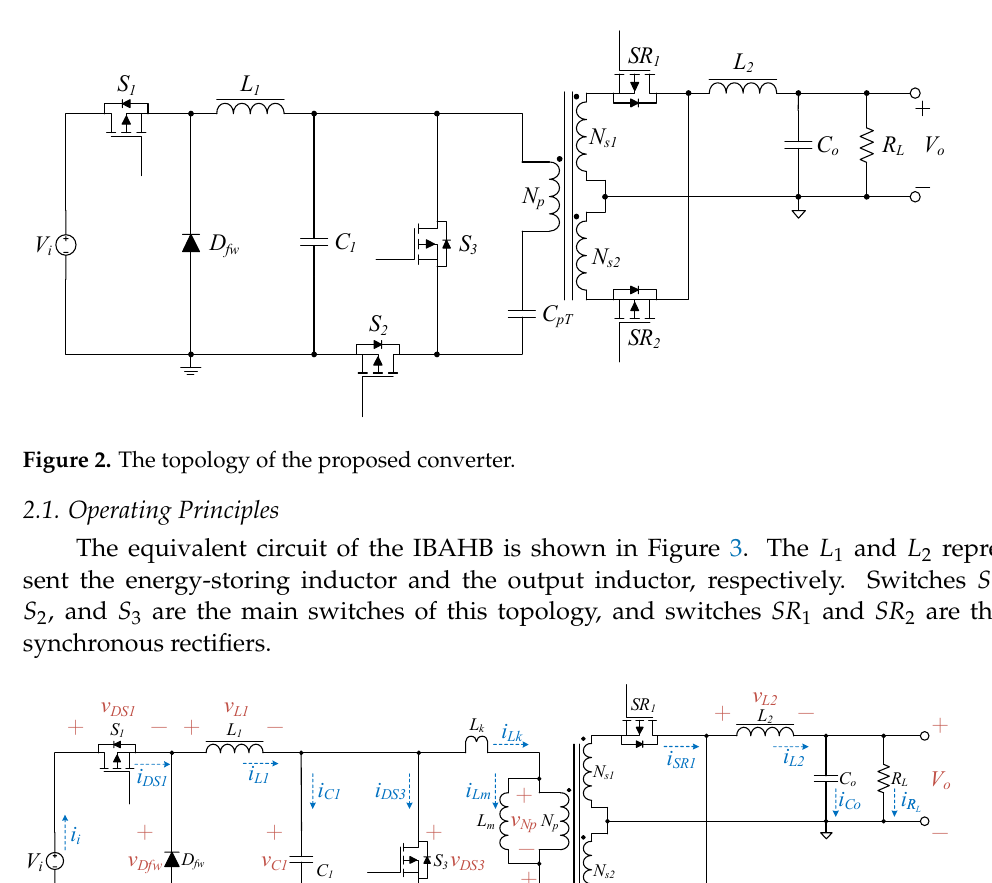
Figure 2. The topology of the proposed converter.